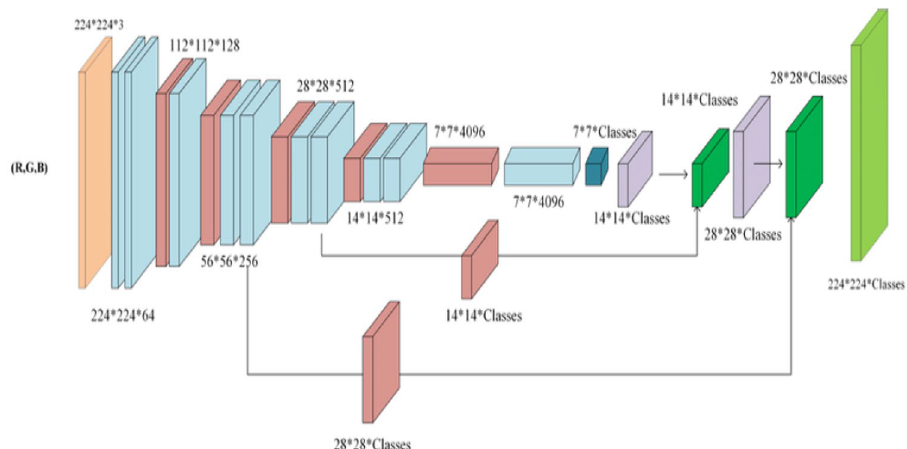
Fig. 5 The architecture of the Fcn8s